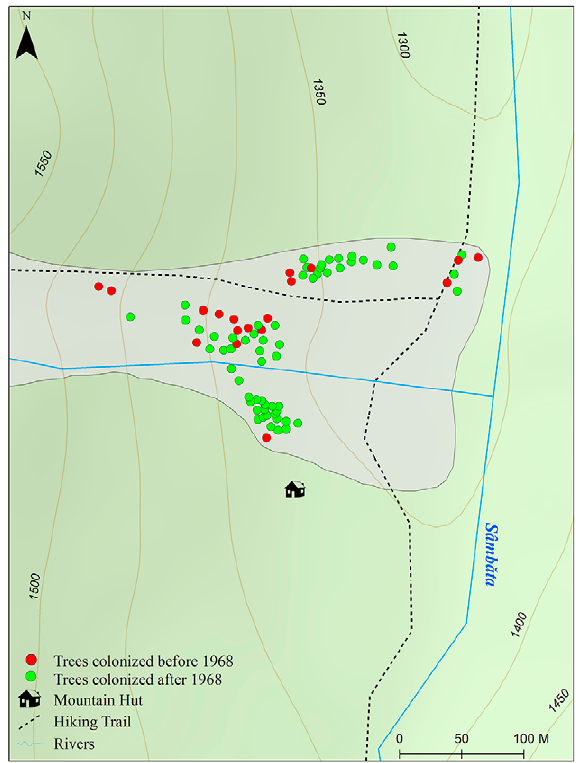
Figure 11. Succession analysis (trees established before the debris flow event in 1968 - RED, trees established after 1968 - GREEN)